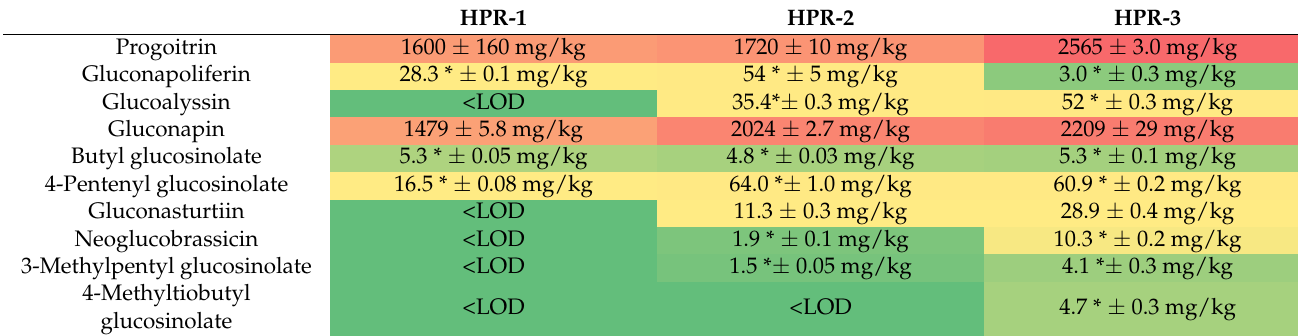
Table 2. Results of determined glucosinolates in different protein products from hot-pressed rapeseed cake (HPR) The concentrationsare shown with different colours. The more solid the red colour, the higher the concentration of glucosinolates; the more solid the green colour, the lower is the concentration of